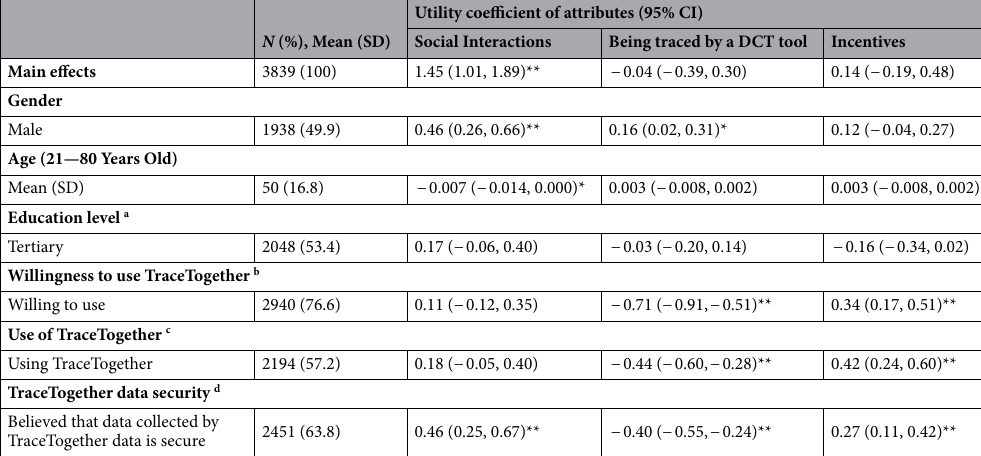
Table 1. Utility coefficients of attributes from the Discrete Choice Experiment. Panel conditional fixed logit analysis of a three-attribute discrete choice experiment, adjusted with covariates. a Tertiary: Diploma and above. b Willing: Respondents “agreed” or “strongly agreed” that they are willing to use the TraceTogether app or token. c Using TraceTogether: Respondents indicated that they were using TraceTogether at the point of the survey. d: Respondents “agreed” or “strongly agreed” that they believed that the data collected by TraceTogether is secure. * p < 0.05. ** p <